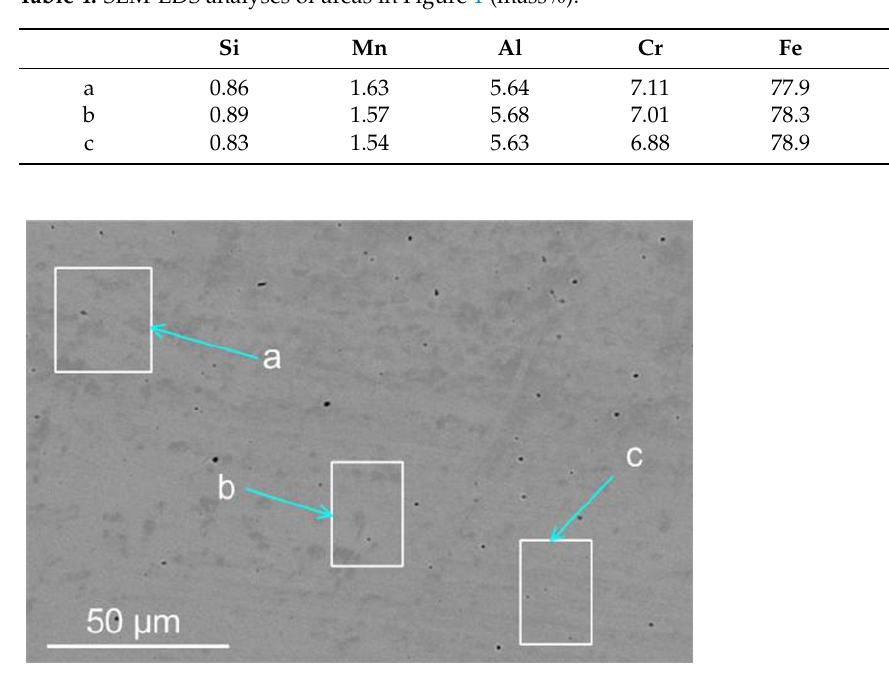
Table 4. SEM-EDS analyses of areas in Figure 1 (mass%).